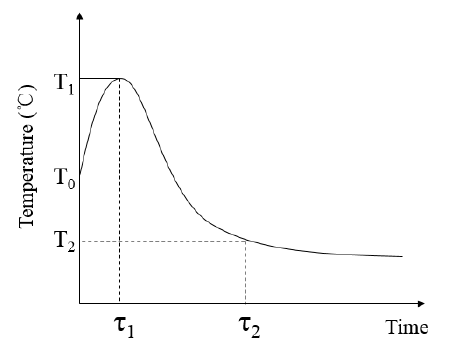
Figure 4. Thermal response of indoor environment.